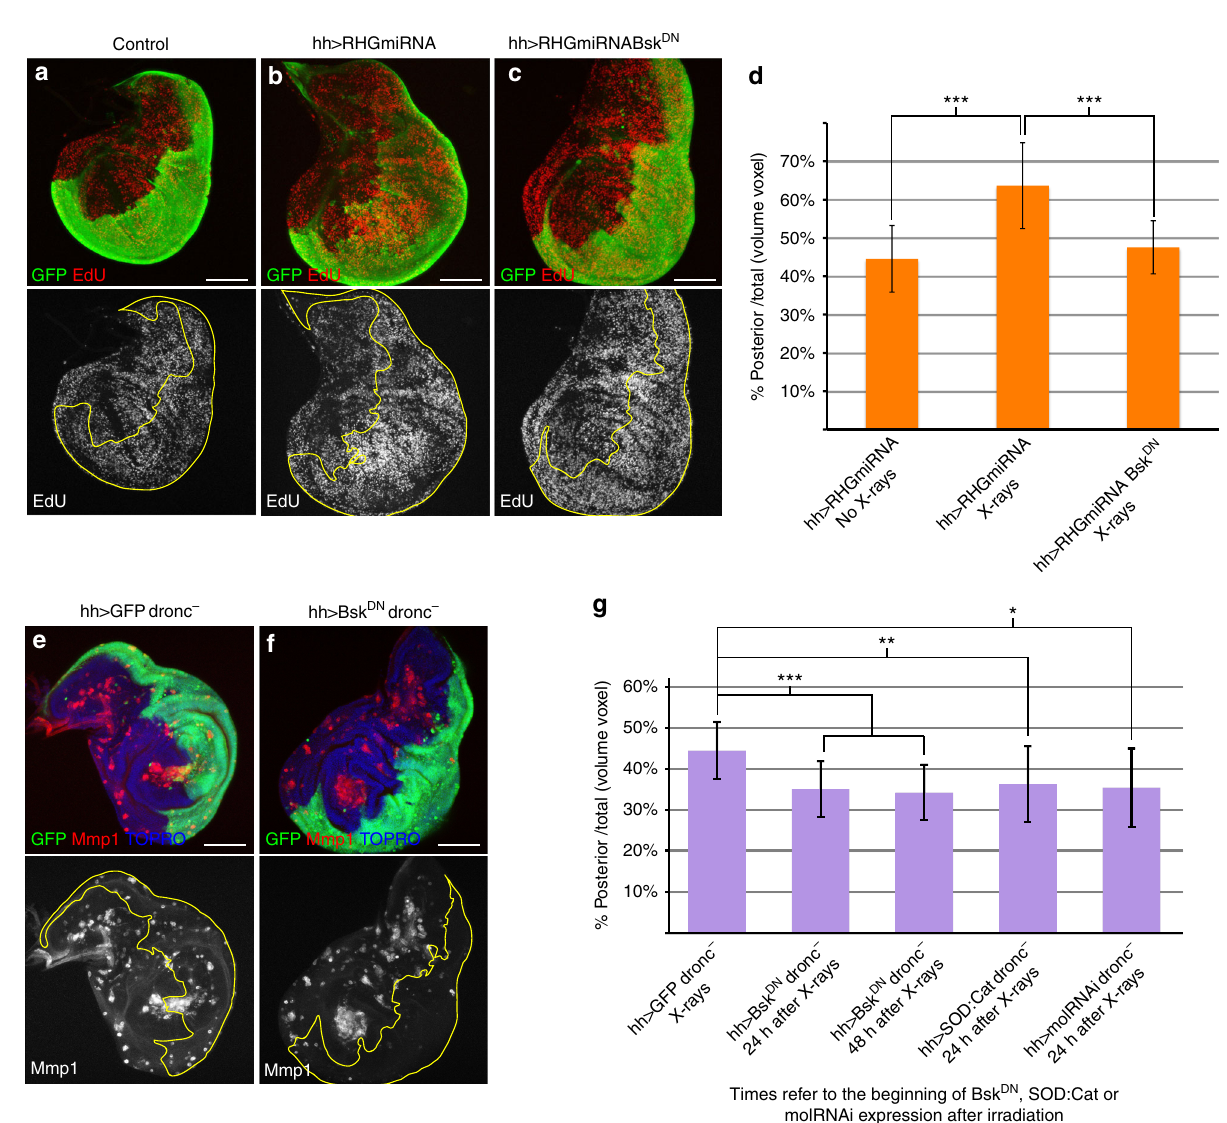
Fig. 4 Persistent JNK activity causes overgrowths. a – c Discs of genotypes: a UAS-GFP;hh-Gal4 ( n = 10), b UAS-RHGmiRNA/UAS-GFP; hh-Gal4/ + ( n = 20) and c UAS-Bsk DN ; UAS-RHGmiRNA/UAS-GFP; hh-Gal4/ + ( n = 11) 72h after X-rays. EdU incorporation (red) is increased in the posterior compartment (green) of b where apoptosis is suppressed by UAS-RHGmiRNA , but when JNK activity is blocked with Bsk DN ( c ), EdU incorporation is similar in both compartments, which